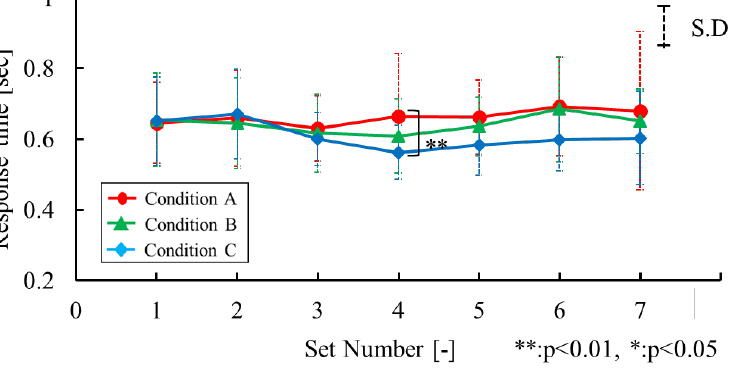
Figure 7. Result of MATH score.